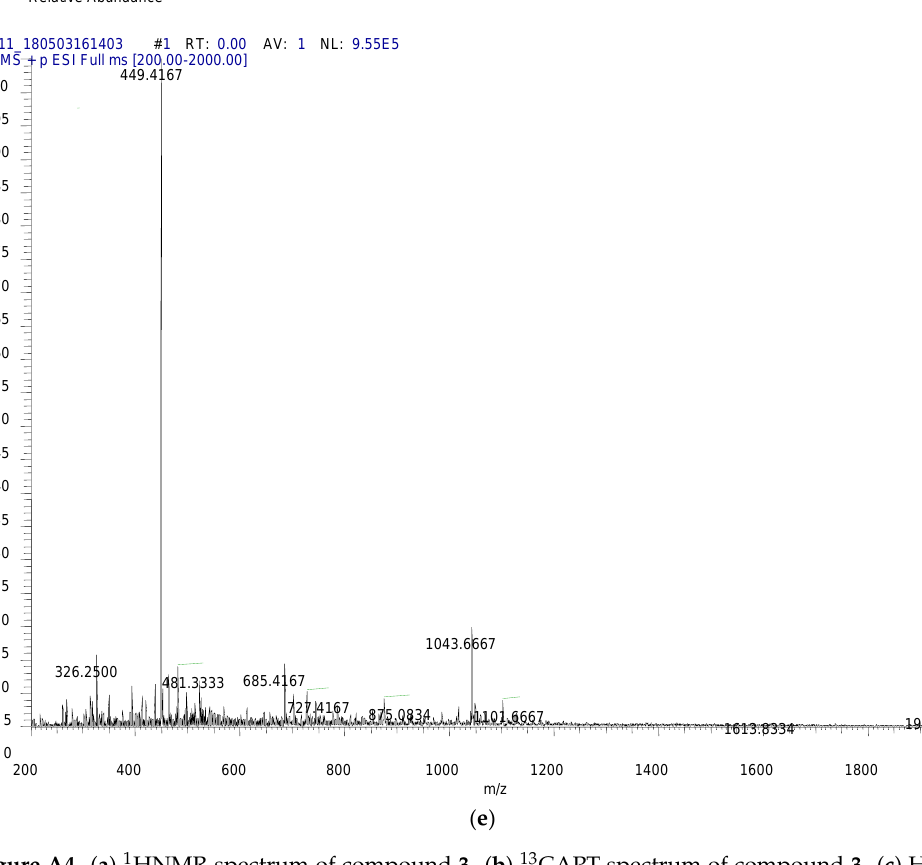
Figure A4. ( a ) 1 HNMR spectrum of compound 3 . ( b ) 13 CAPT spectrum of compound 3 . ( c ) HSQC spectrum of compound 3 . ( d ) HMBC spectrum of compound 3 . ( e ) ESIMS spectrum of compound 3 .